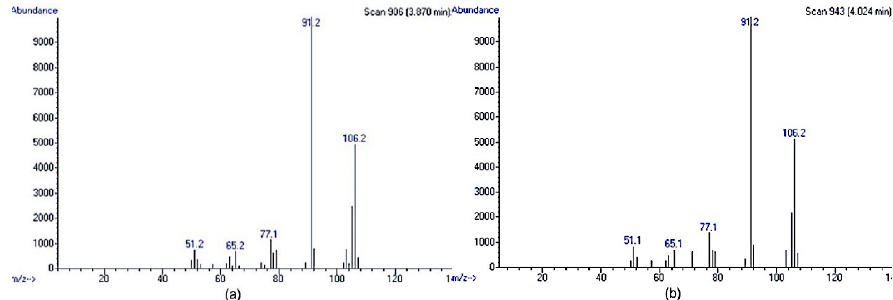
Figure 3. Mass spectrometry of m -xylene and p -xylene ( a ) and o -xylene ( b ).